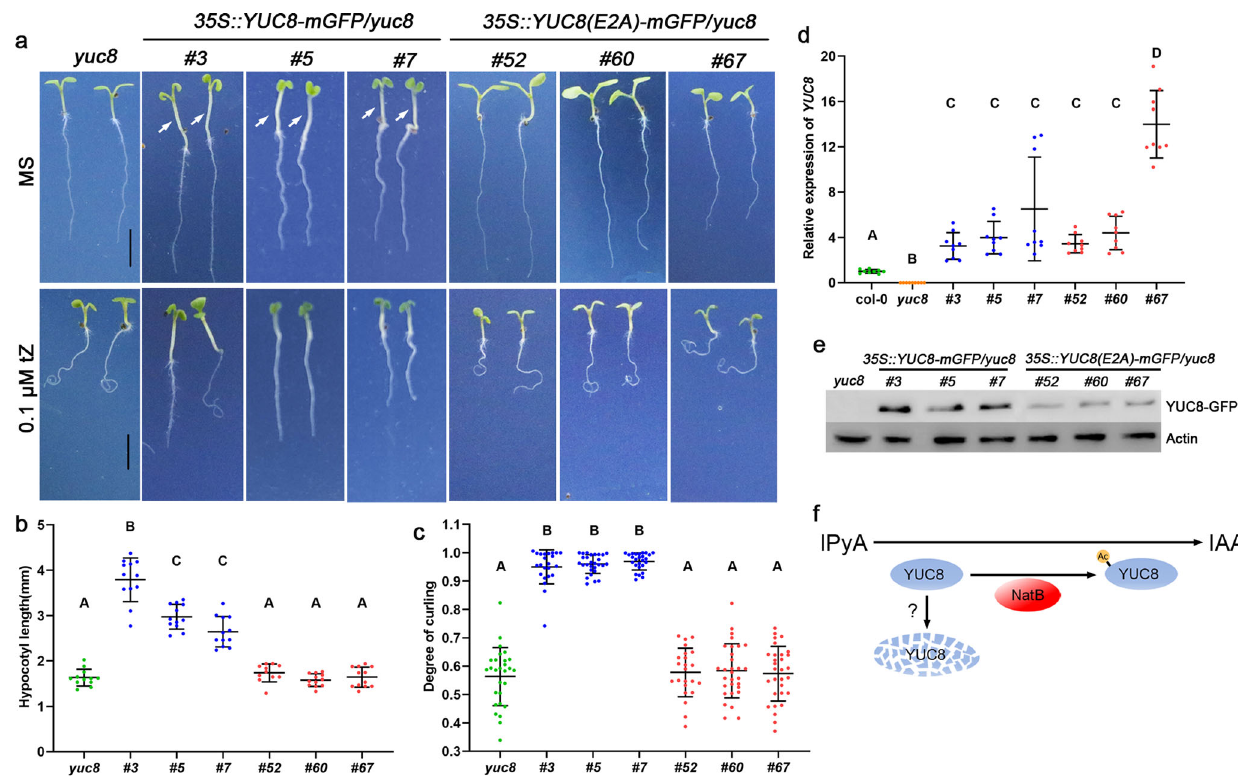
Fig. 4 NatB-mediated NTA of YUC8 is determined by N-terminal Aa and is essential for its intracellular stability to function in auxin biosynthesis. a Phenotypes of yuc8 mutant and transgenic yuc8 plants harboring YUC8/YUC8(E2A)-mGFP at 7 DAG on MS media with or without 0.1 μΜ tZ, bar = 5 mm. b , c Quanti fi cation of Hypocotyl length (MS, n ≥ 11) and degree of root curling (0.1 μΜ tZ, n ≥ 23). Data are presented as mean ± SD, different capital letters indicate signi fi cant differences at P < 0.01 according to ANOVA followed by Tukey ’ s multiple comparison tests. d YUC8 expression levels determined by qRT-PCR. Data are presented as mean ± SD of three independent experiments, different capital letters indicate signi fi cant differences at P < 0.01 according to ANOVA followed by Tukey ’ s multiple comparison tests. e YUC8-mGFP fusion protein levels determined by Western analysis using anti-GFP antibody, ACTIN as internal reference. f A proposed model elucidating the role of NatB in controlling the auxin